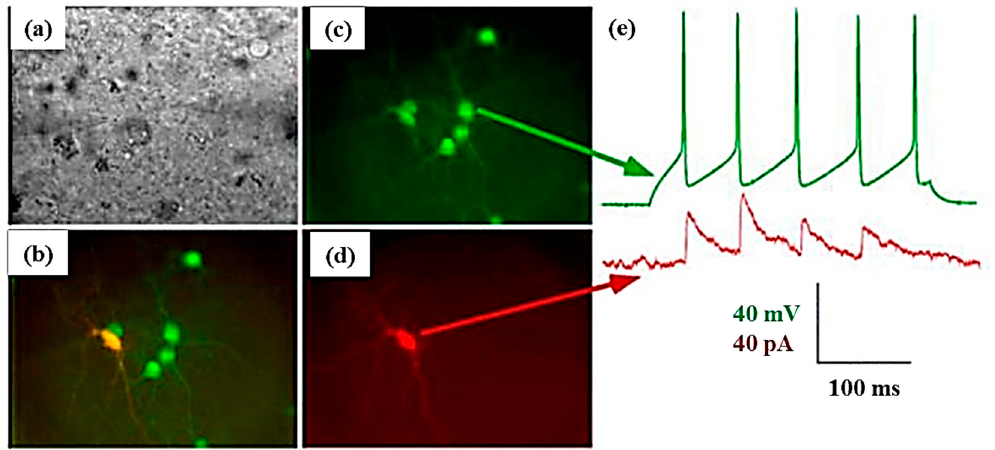
Figure 9. Testing of viral spread in the pre- and post-synaptic cells. ( a ) Image of the slice and recording pipettes with cells. ( b ) Merger of the fluorescent image. ( c ) Transfected cell with viral spread. ( d ) Transfected cell with TVA (cellular receptor for subgroup A avian leukosis viruses (ALV-A)) and rabies-virus glycoprotein ( e ) coinciding postsynaptic currents and action potentials in the cell with a monosynaptic connection. Reprinted with the permission of [107].